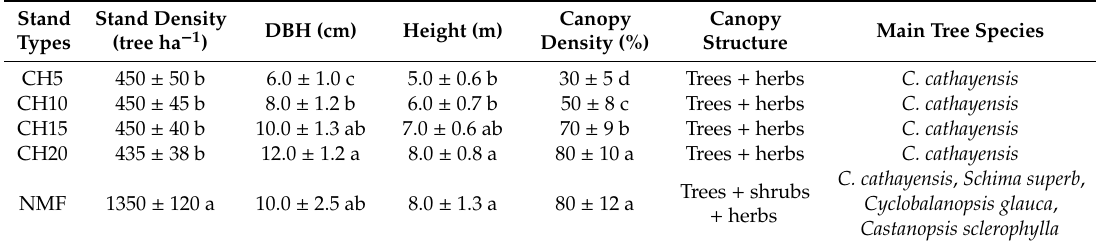
Canopy Canopy Density (%) Structure